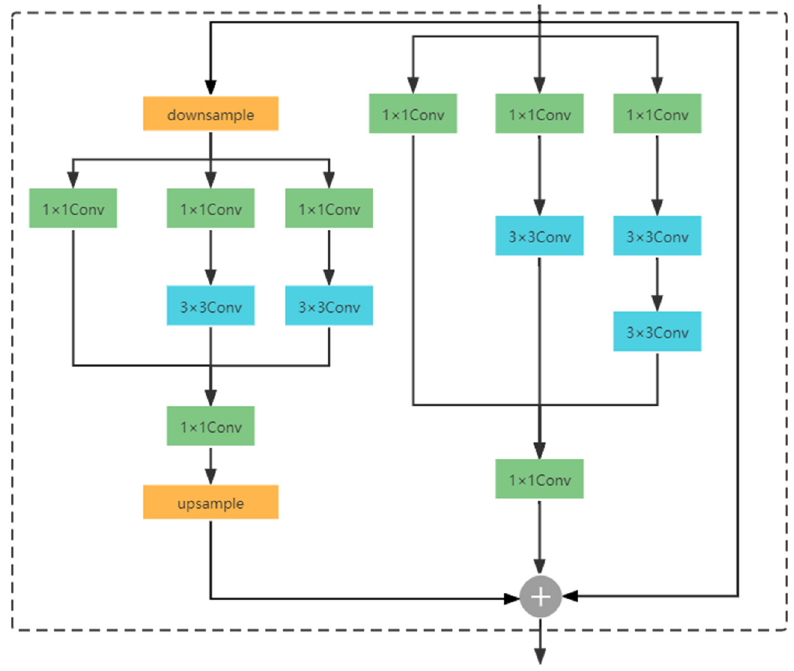
Figure 5. EIRM structure diagram.